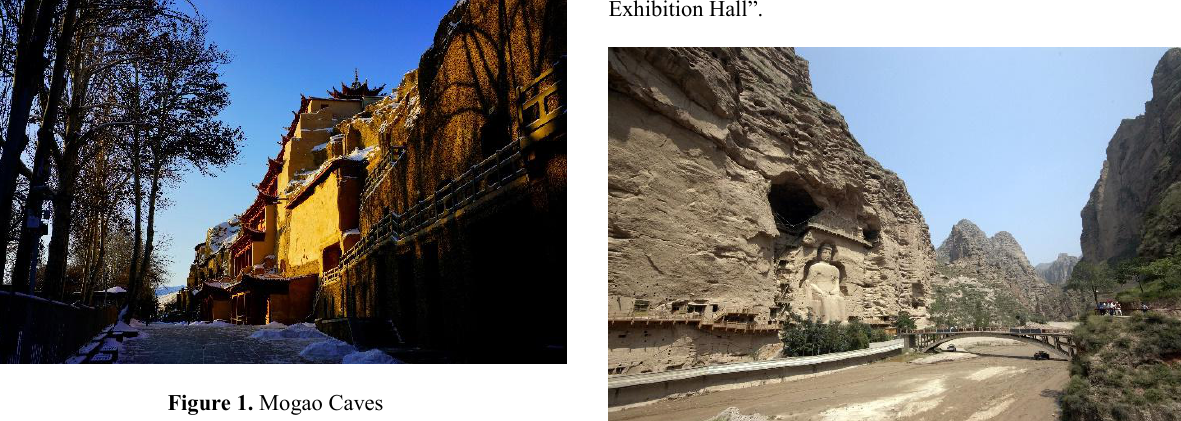
Figure 1. Mogao Caves